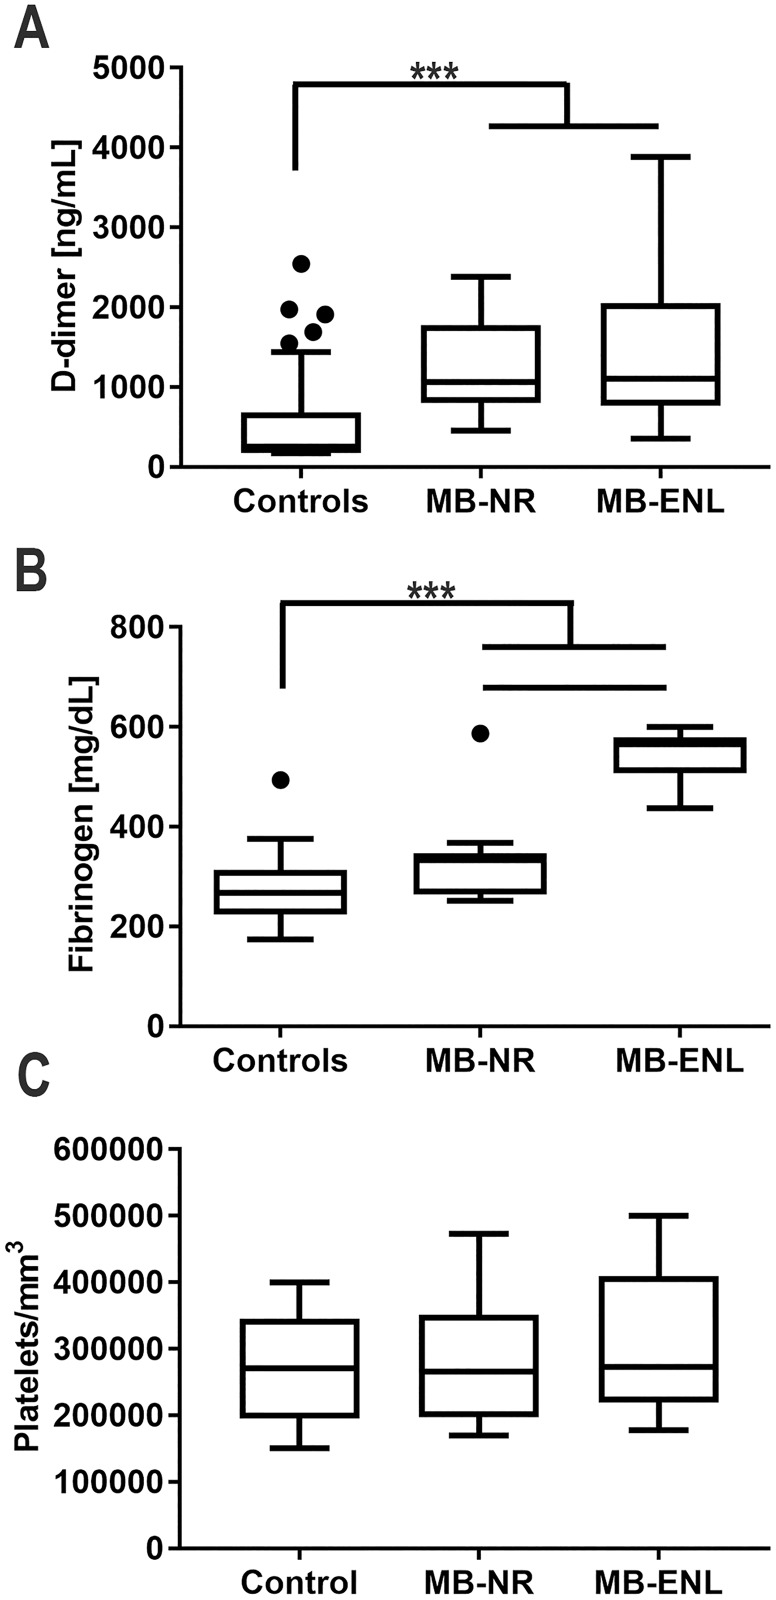
Multibacillary leprosy patients present a procoagulant phenotype.Coagulation parameters were determined on plasma from 50 non-leprosy patients (Controls), 9 non-reactional multibacillary leprosy patients (MB-NR) and 15 multibacillary erythema nodosum leprosum patients (MB-ENL). A) Fibrinogen and B) d-dimer plasma concentrations were determined. C) Platelet counting showed no alteration among samples. MB-NR group are composed by 10LL and 1 BL patients. MB-ENL group are composed by 13 LL and 1 BL individuals. * indicate p<0.01 and *** indicate p<0.0001 with ANOVA.